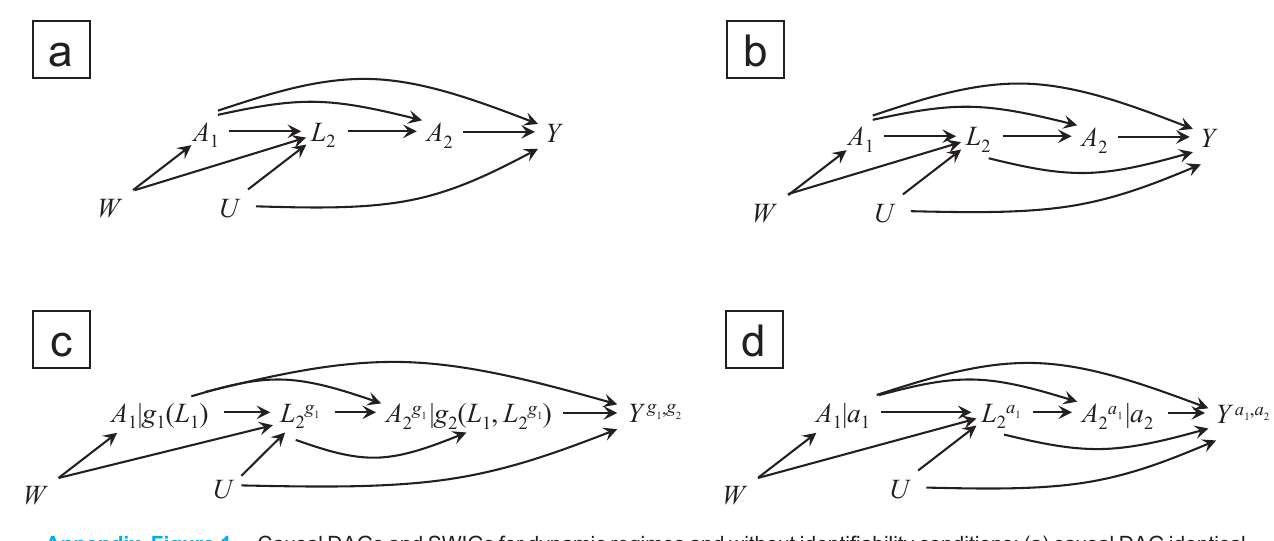
Appendix Figure 1. Causal DAGs and SWIGs for dynamic regimes and without identi fi ability conditions: (a) causal DAG identical to Figure 1(b); (b) causal DAG with the arrow from L 2 on Y , in which L 2 is a ff ected by A 1 , and the A 1 – L 2 association is confounded by unobserved W ; (c) a “ template ” under intervention g = ( g 1 , g 2 ) = ( g 1 ( L 1 ), g 2 ( L 1 , A 1 , L 2 )) of SWIG that corresponds to causal DAG (a); (d) a “ template ” under intervention ( a 1 , a 2 ) of SWIG that corresponds to causal DAG